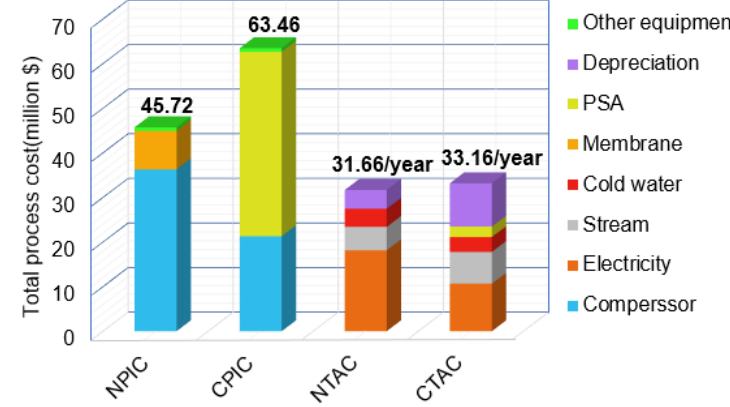
Figure 10. Economic comparison between the traditional process and the novel one. CTAC: Conventional process total annual cost; CPIC: conventional process investment cost; NTAC: novel process total annual cost; NPIC: novel process investment cost. The bright yellow in CTAC represents the annual operation cost of